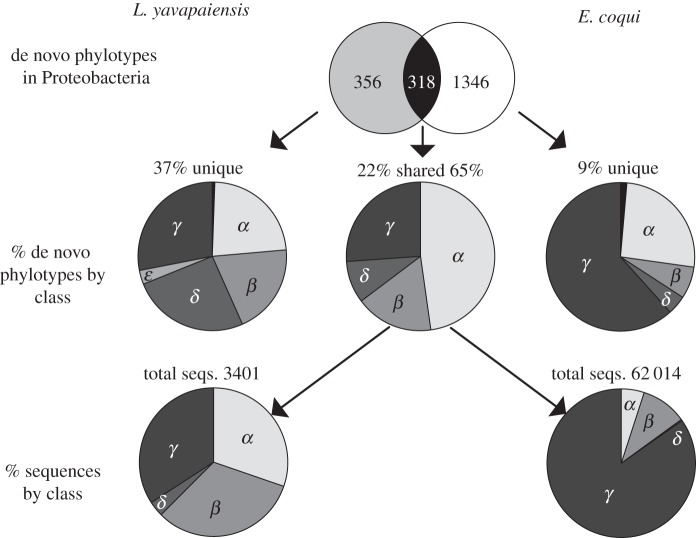
Relative abundance and distribution of 16S V4 Proteobacteria phylotypes by class after rarefaction at 5000 reads per individual. Venn diagram shows the total number of unique or shared phylotype sequences by species, whereas the pie charts represent the distribution of reads by class. We considered % unique as the total number of unique Proteobacteria reads for each species divided by total number of sequences (% unique Ly=5483/15 000; % unique Ec=8325/95 000). Similarly, we considered % shared as the total number of Proteobacteria reads shared between species divided by the total number of sequences (% shared Ly=3401/15 000; % shared Ec= 62 014/95 000).